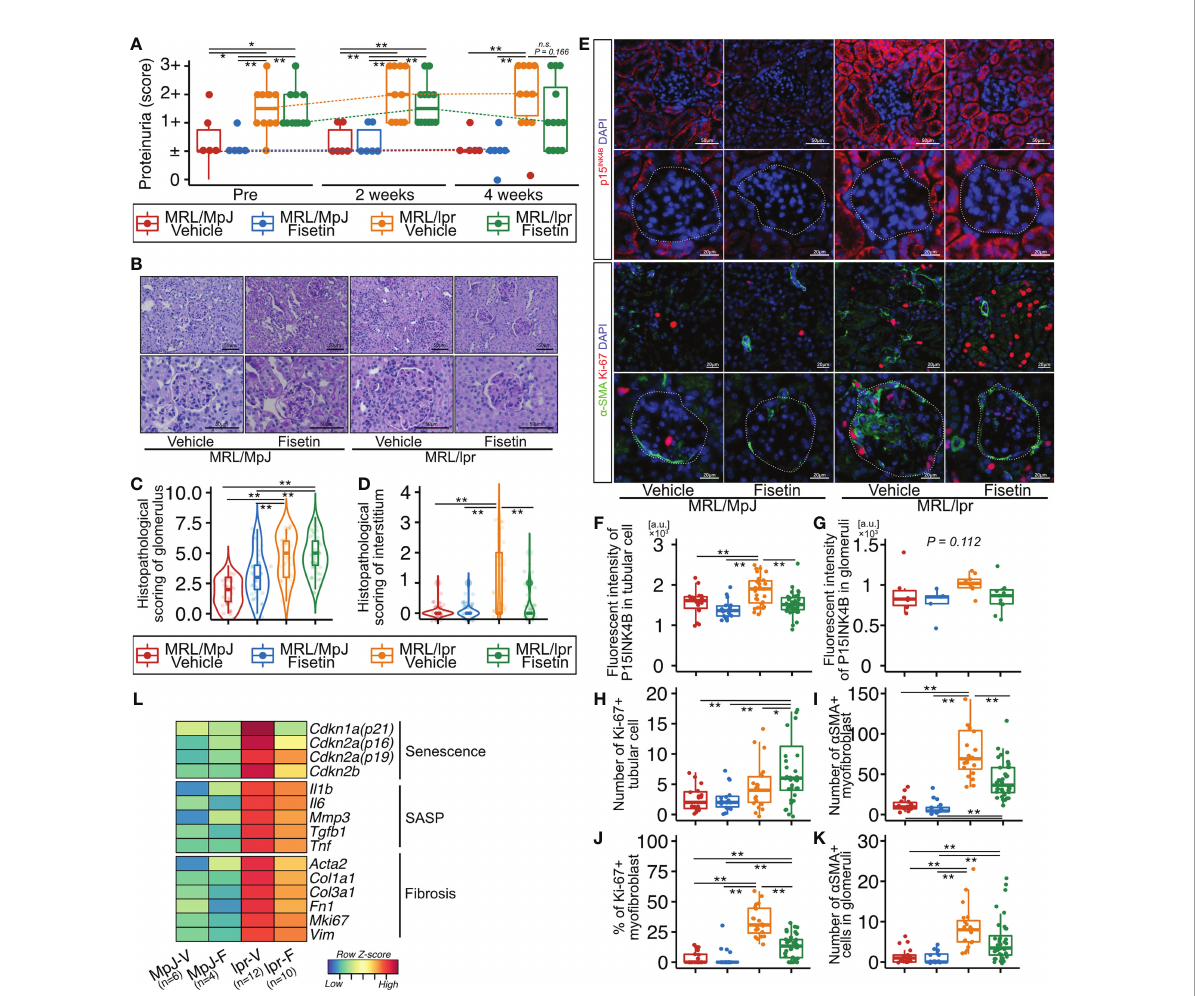
FIGURE 5 In vivo fi setin treatment reduces expression of p15 INK4B and SASP genes and inhibits a -SMA – positive myo fi broblasts in MRL/lpr mice. (A) Semi- quantitative data of proteinuria after fi setin treatment. (B – D) Representative images of PAS-stained kidneys from vehicle- and fi setin-treated MRL/MpJ and MRL/lpr mice (B) , and quanti fi cation of the histopathological scores of the glomeruli and interstitium (C , D) . (E) Representative images of immunohistochemical staining for p15 INK4B in kidney sections from MRL/lpr and MRL/MpJ mice after fi setin treatment. (F – H) Quanti fi cation of fl uorescence intensity of p15 INK4B expression in tubular cells and glomeruli (F, G) and the number of Ki-67-positive tubular cells (H) . (I, J) Quanti fi cation of the number of a -SMA – positive cells (I) and the percentage of Ki-67- and a -SMA-positive cells in the interstitium (J) . (K) Quanti fi cation of the number of a -SMA-positive cells in glomeruli. (L) Heatmap of differentially expressed senescence-, fi brosis-, and SASP-related genes. Higher expression is depicted in red, lower expression is depicted in blue, and equivalent expression is depicted in yellow. Data are presented as medians with IQRs and 1.5 times the IQR and are displayed as dot plots and box-and-whisker plots. P -values were determined using one-way ANOVA adjusted by Tukey ’ s method. (* P < 0.05 and ** P <